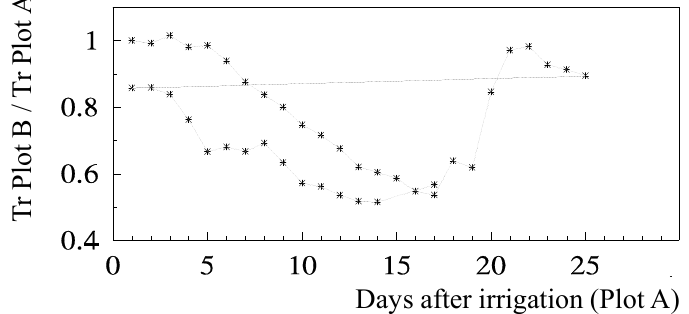
Figure 5. Relationship between RTr and the number of days since last irrigation in the stressed Plot B, during two stress cycles in relation to well-irrigated Plot A, in a peach orchard (adapted from [78]). The horizontal line connects the last recovery day to the second stress cycle.